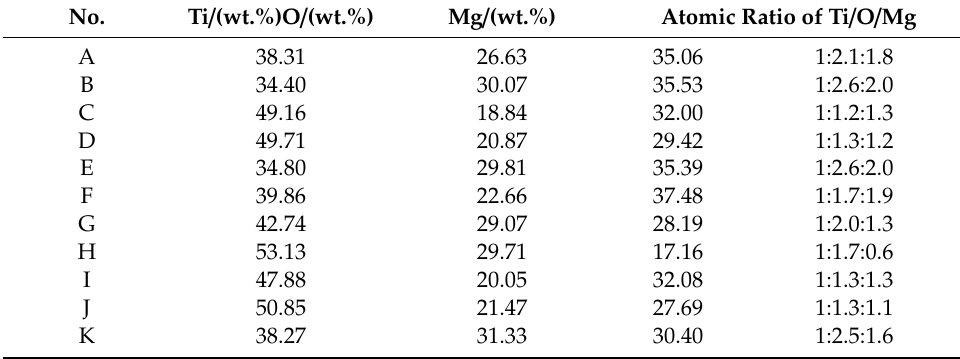
Table 2. EDS results of SHS products at different sample preparation pressures.